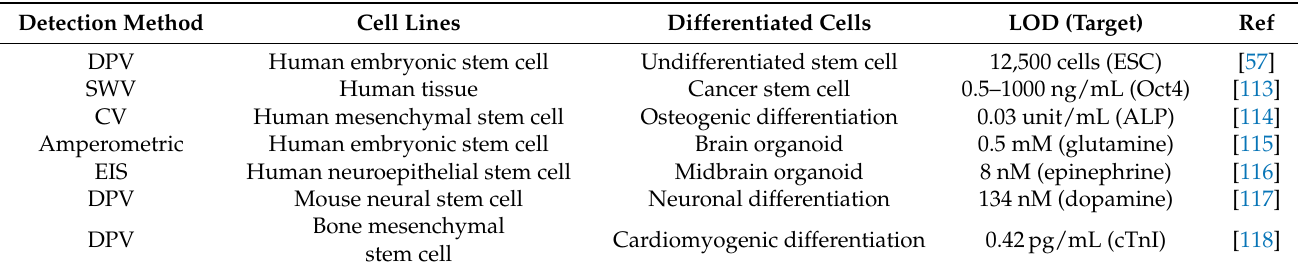
Table 3. Electrochemical biosensing platforms for stem cell